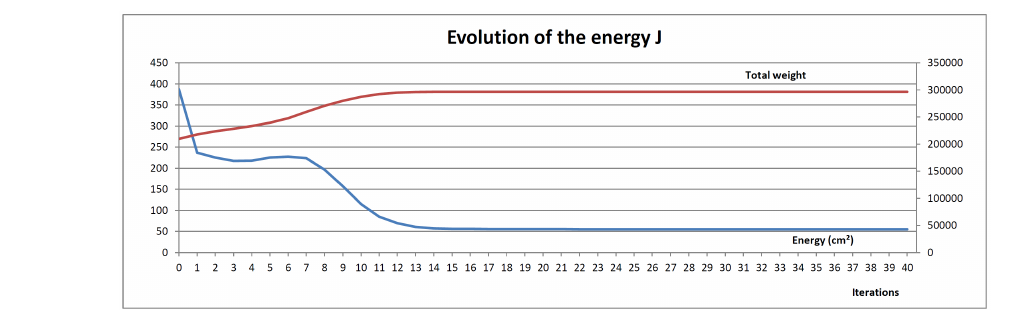
Table 11. Final errors of the intrinsic parameters of synthetic point cloud #1